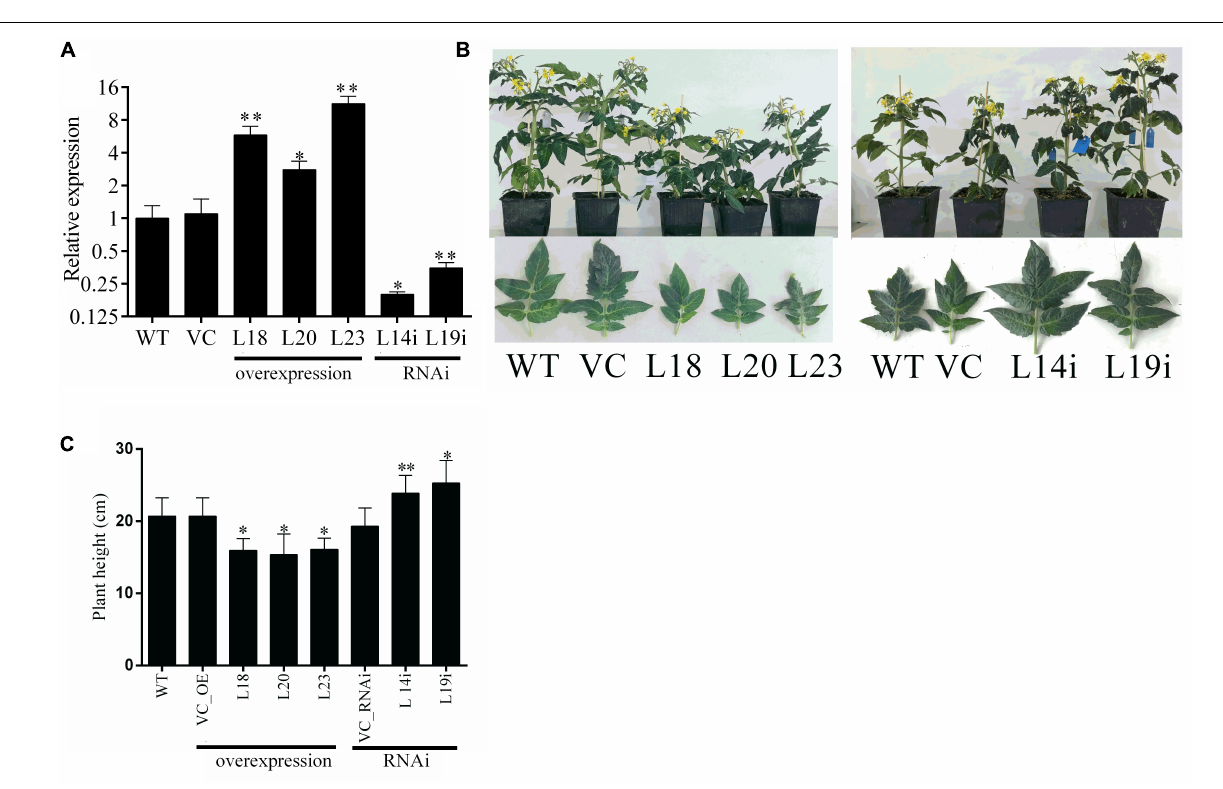
Frontiers in Plant Science |